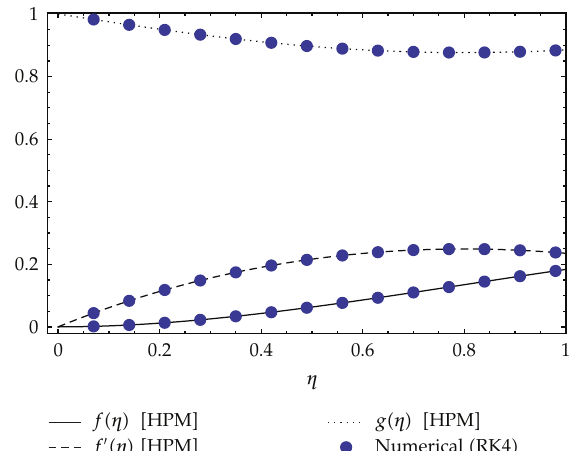
Figure 2: The normalized radial velocity profiles for the rotating flow obtained by the 8th-order approximation of the HPM in comparison with the numerical solution, when δ (cid:7) 0 . 8.